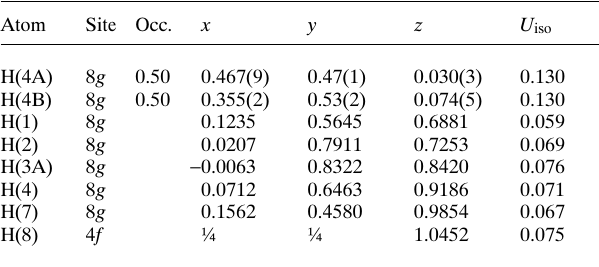
Table 2. Atomic coordinates and displacement parameters (in Å 2 )